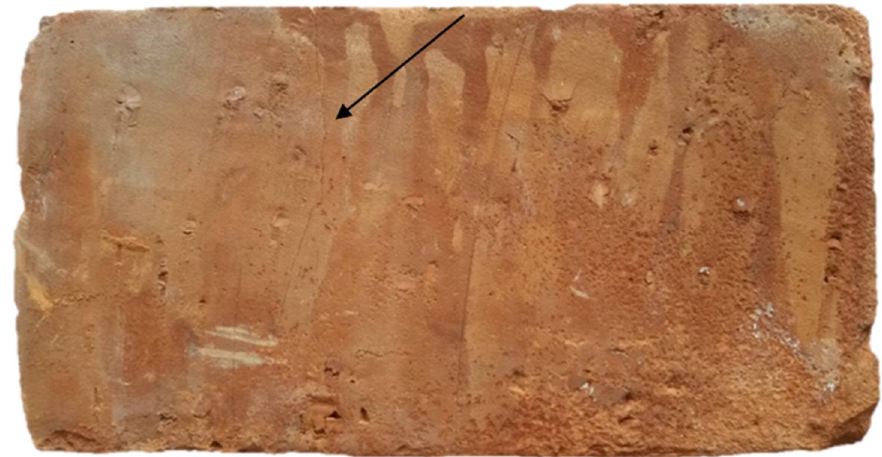
Figure 7. Clear fracture of the full ceramic brick after the strength test.